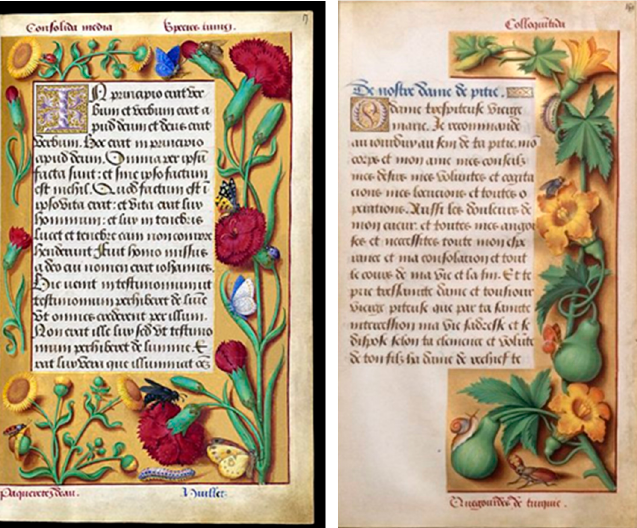
Figure 19. Jean Bourdichon ( France, 1457–1521). Les Grandes Heures d’Anne de Bretagne , 1503–1508,